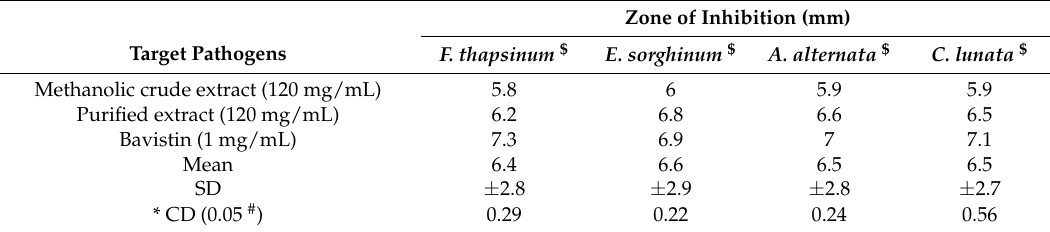
Table 1. Antifungal activity of methanolic extract of Eclipta alba (Agar well diffusion assay).